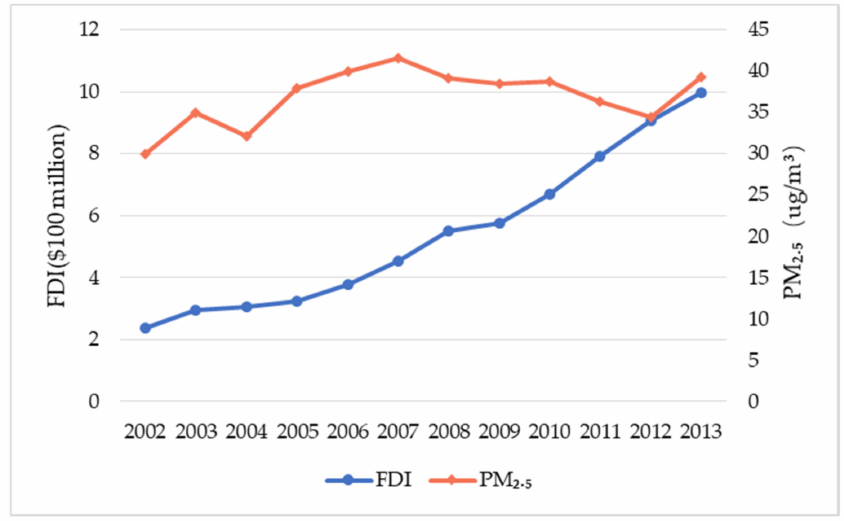
Figure 2. Average FDI and PM 2.5 of 271 cities in China from 2002 to